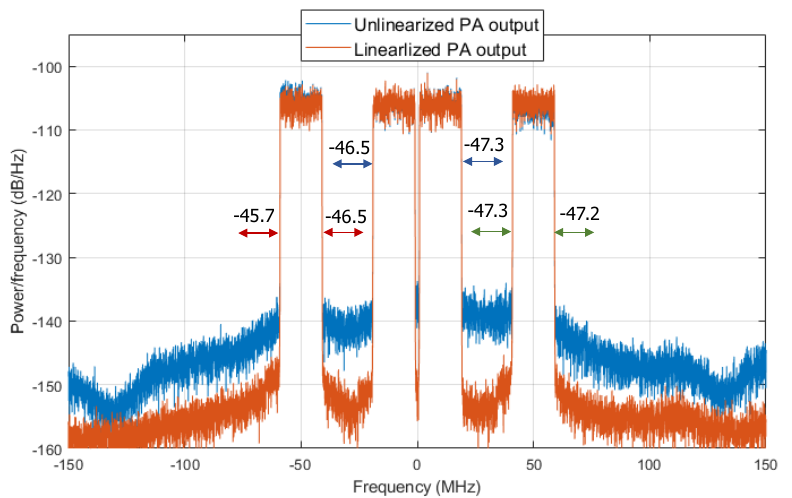
Figure 14. Spectra of both the linearized and unlinearized PA output signal, considering 41 coeffi- cients of a GMP behavioral model selected with